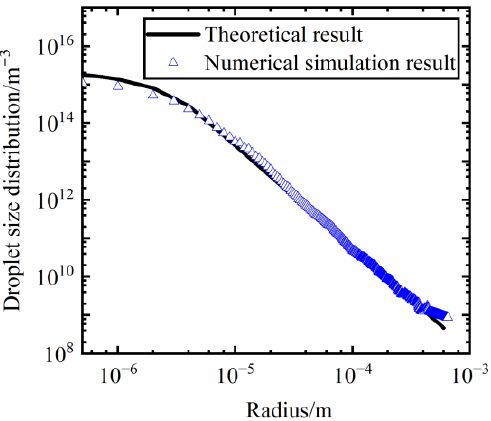
Figure 6. Comparison of droplet size distribution between numerical simulation and theoretical model [11,43].